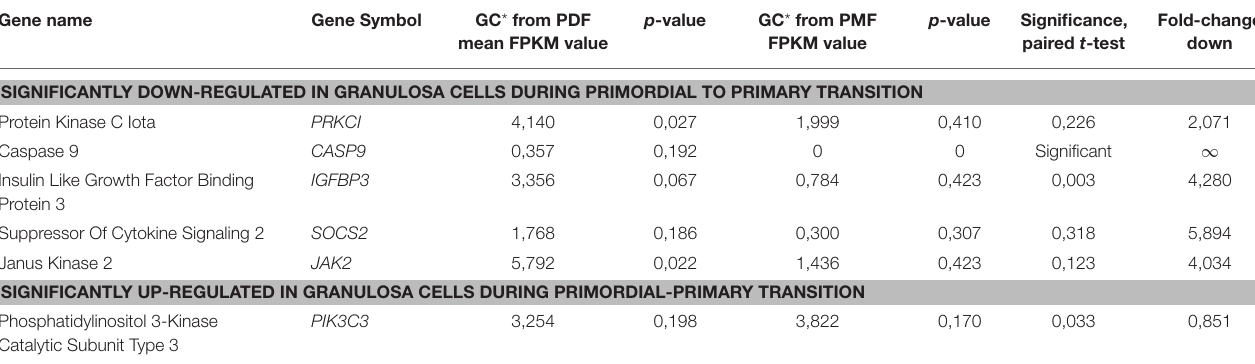
TABLE 7 | Differently expressed genes annotated “IGF1 Signaling”